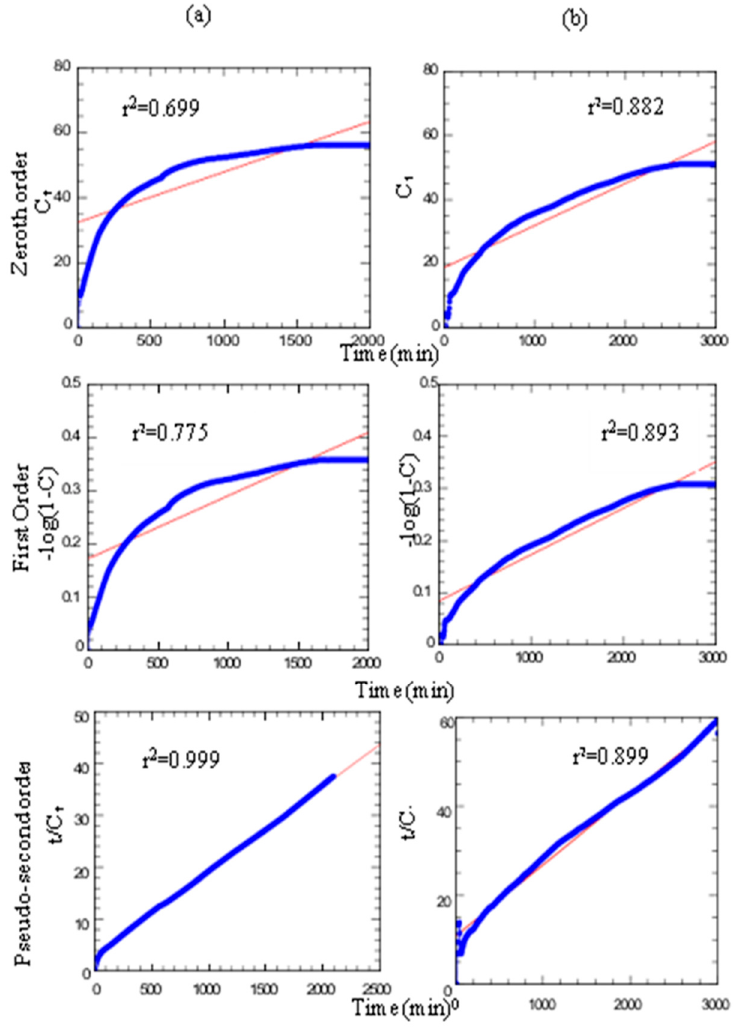
Figure 9. Fitting the release of 3,4D ( a ) and TBA ( b ) from ZADTX nanocomposite to the zeroth- order, first-order, pseudo-second-order and parabolic diffusion kinetics models.